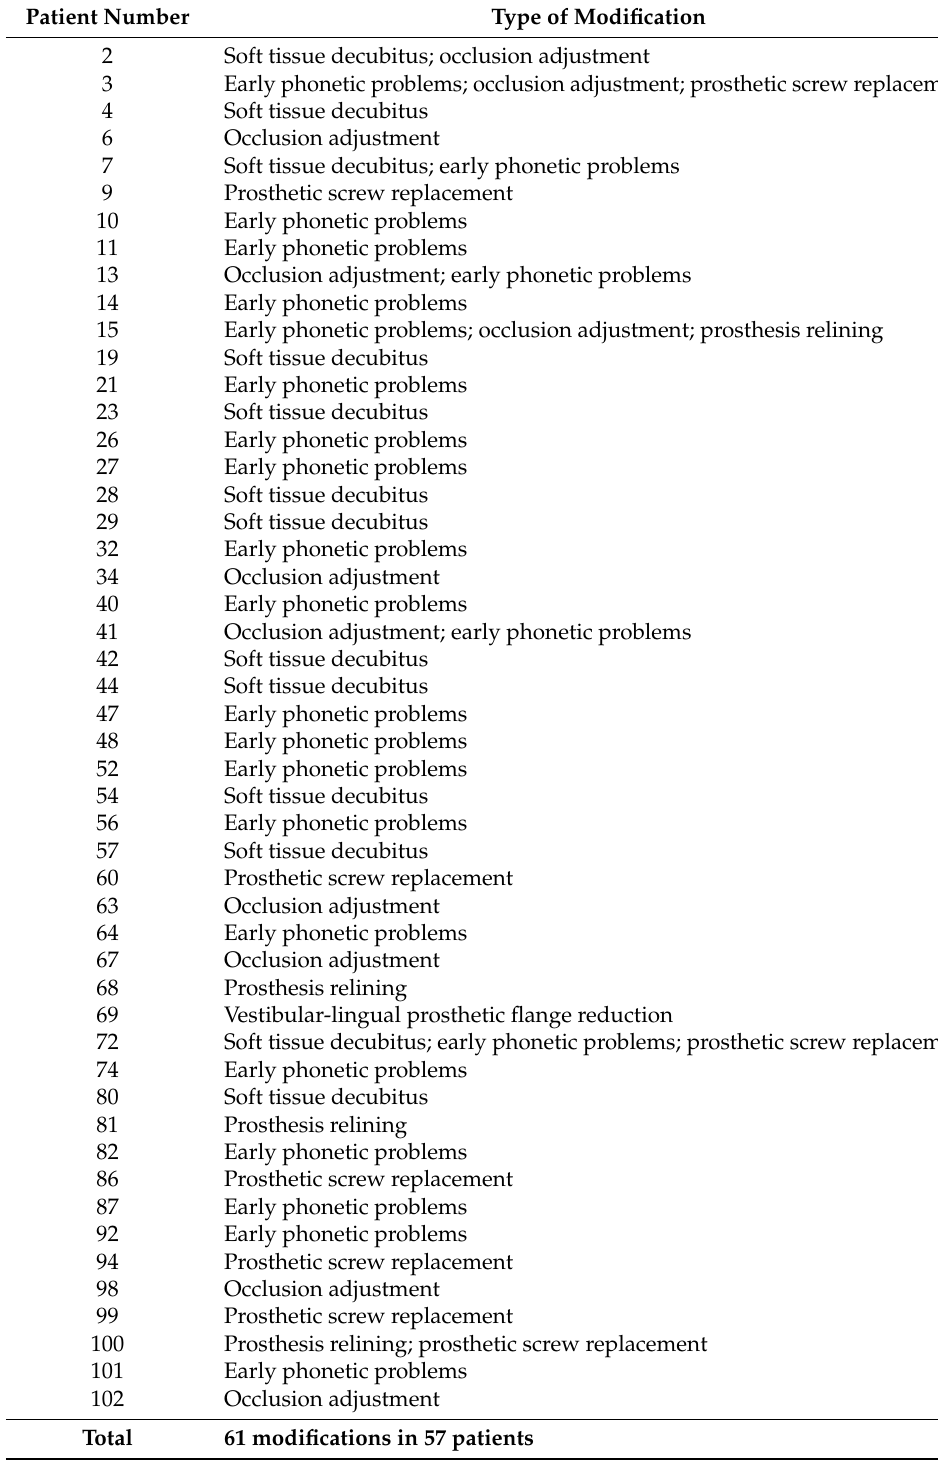
Table 4. Description of normal prosthetic modifications up to seventh year in